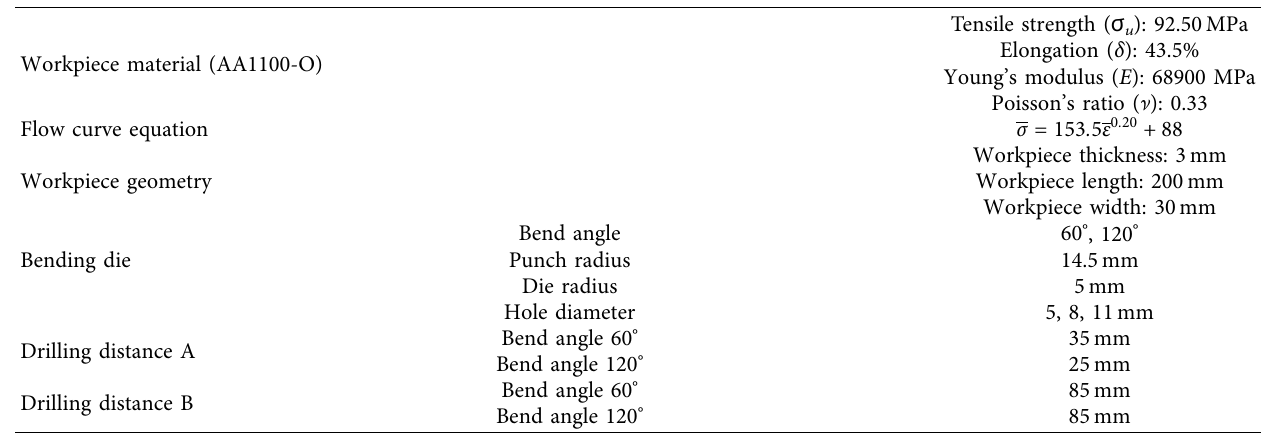
Table 1: Experimental